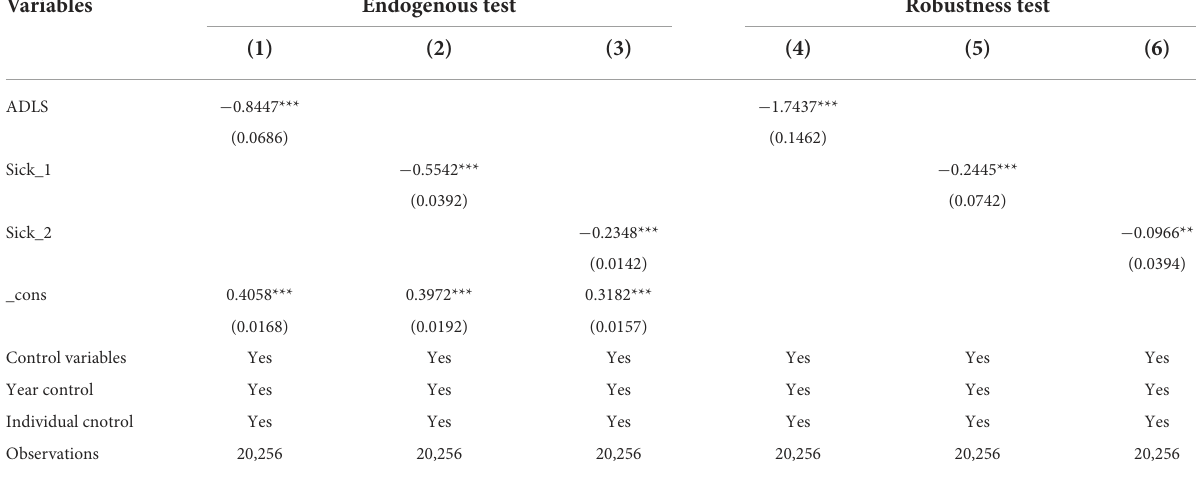
TABLE 4 Results of endogenous test and robustness